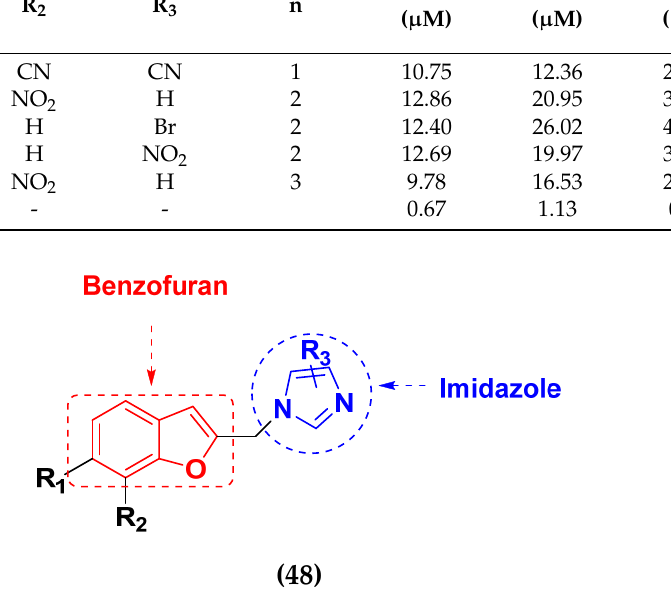
Figure 54. Structure of imidazole based benzofuran hybrid derivative 48. Table 41. In vitro cytotoxic activities of imidazole-based benzofuran hybrid compounds 48 ( a – e ).